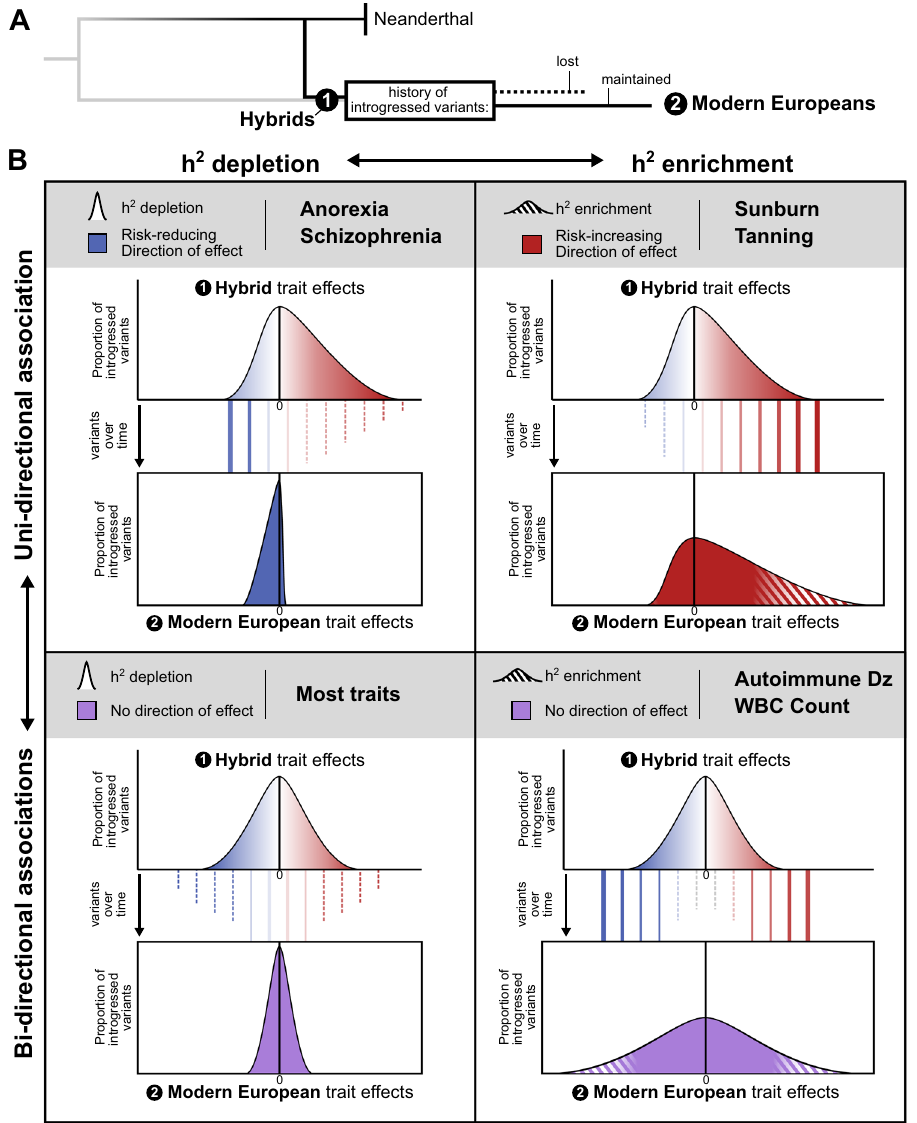
Fig. 5 Patterns of heritability and direction of effect suggest contrasting selective pressures on introgressed variation associated with different traits. A After admixture, many Neanderthal variants segregated in hybrid populations. As these populations evolved into modern Eurasians, some introgressed variants were lost due to drift or negative selection (dashed line) and some were maintained due to drift or positive selection (solid line). B With regards to introgressed variants in modern Europeans, traits fall into four general quadrants on the axes of heritability enrichment vs. depletion ( x -axis) and uni- directional vs. bi-directional trait effects ( y -axis). For each quadrant, we depict potential variant histories and selective pressures leading to the observed distribution of introgressed variants ’ trait effects (solid and dashed lines). (Bottom Left) Heritability for most traits is depleted among introgressed variants (narrow effect distribution with most variants conferring no effect) with no bias in the direction of effect (centered at zero). This suggests selection against introgressed variants that in fl uenced these traits. (Top Right) The opposite pattern is observed in traits such as sunburn and tanning. These traits are enriched for heritability among introgressed variants (thick tail with more variants conferring trait effects than expected), and they have a bias in their direction of effect (skewed). This pattern suggests that introgression introduced some functional alleles that were positively selected in AMHs. (Bottom Right) Traits, like autoimmune disease risk and white blood cell (WBC) count, have heritability enrichment among introgressed variants (thick tails with many variants conferring trait effect), but no directional bias (centered). In this case, introgression likely contributed increased diversity relevant to the trait — both trait-increasing and -decreasing — into AMHs that was bene fi cial as they adapted to non-African environments. (Top Left) Finally, traits like anorexia and schizophrenia, show depletion for heritability among introgressed variants (narrow distribution), but they have a signi fi cant directionality bias in the few introgressed variants with effects (skewed). This pattern could be produced by negative selection purging most introgressed alleles that in fl uence the trait paired with selection for a small number of introgressed bene fi cial since admixture on introgressed variation associated with different a small number of introgressed protective alleles. Supporting this traits. Further work is needed to determine how these introgressed interpretation, the remaining Altai-matching variation has the variants in fl uence traits and resolve the dynamics of selection. strongest correlation with protective bene fi t against serious fi tness- Our results expand the current understanding of the functional reducing diseases (anorexia and schizophrenia) 73 . In summary, our results reveal signatures of contrasting patterns of selection effects of introgressed variants in several dimensions. First,